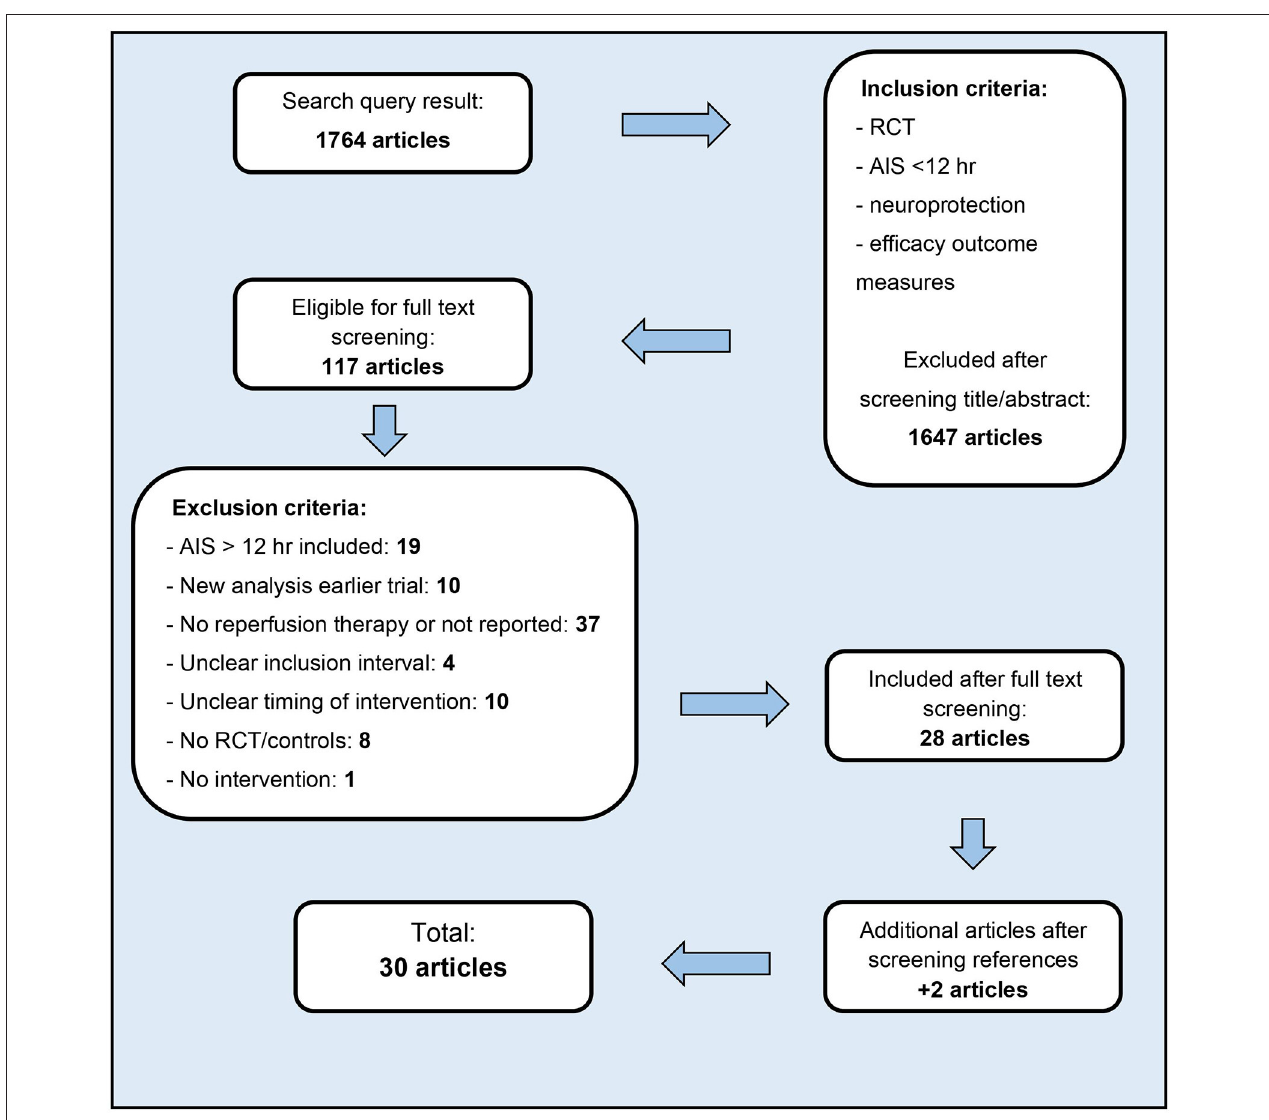
FIGURE 1 | Article